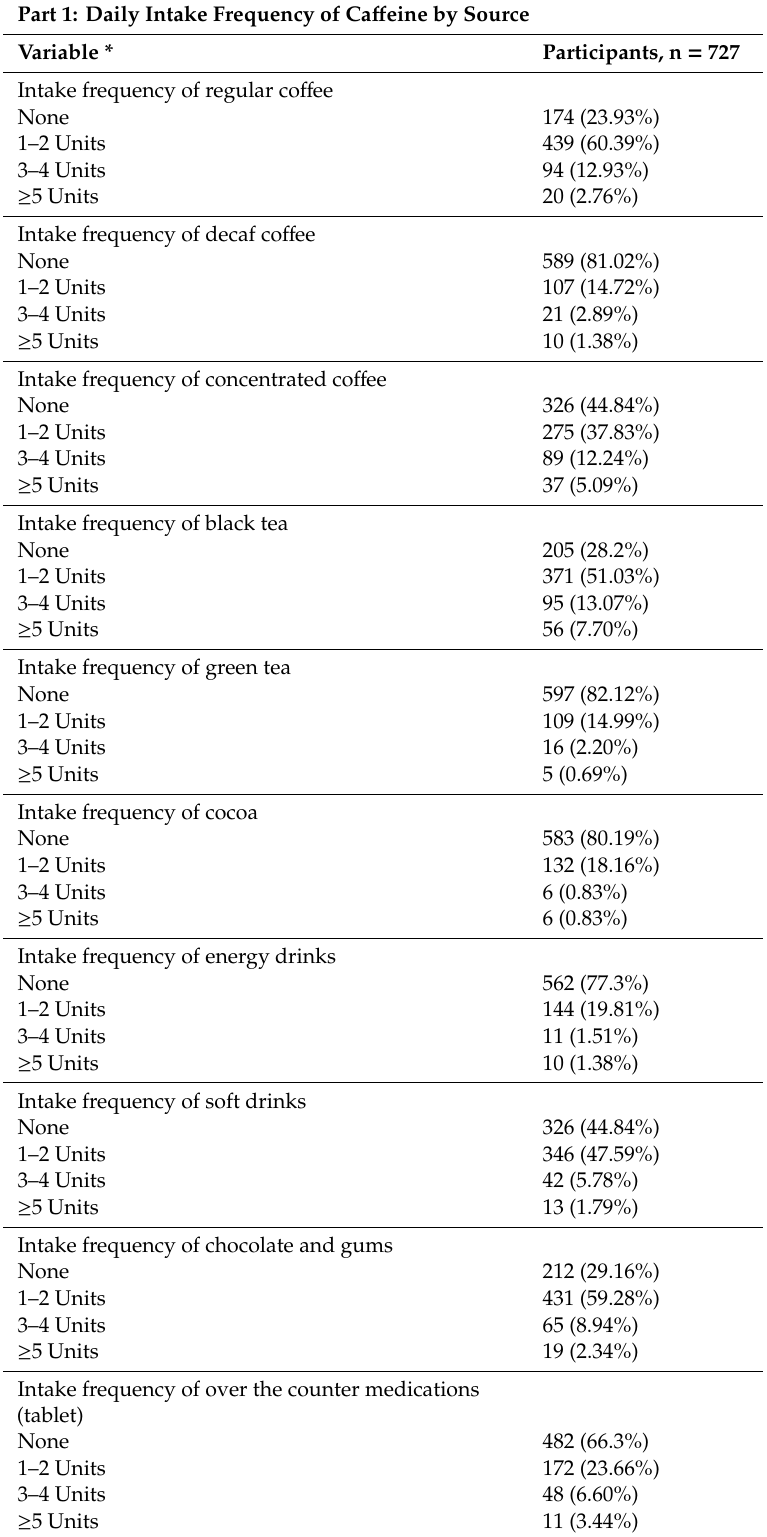
Table 2. Daily ca ff eine intake by the study